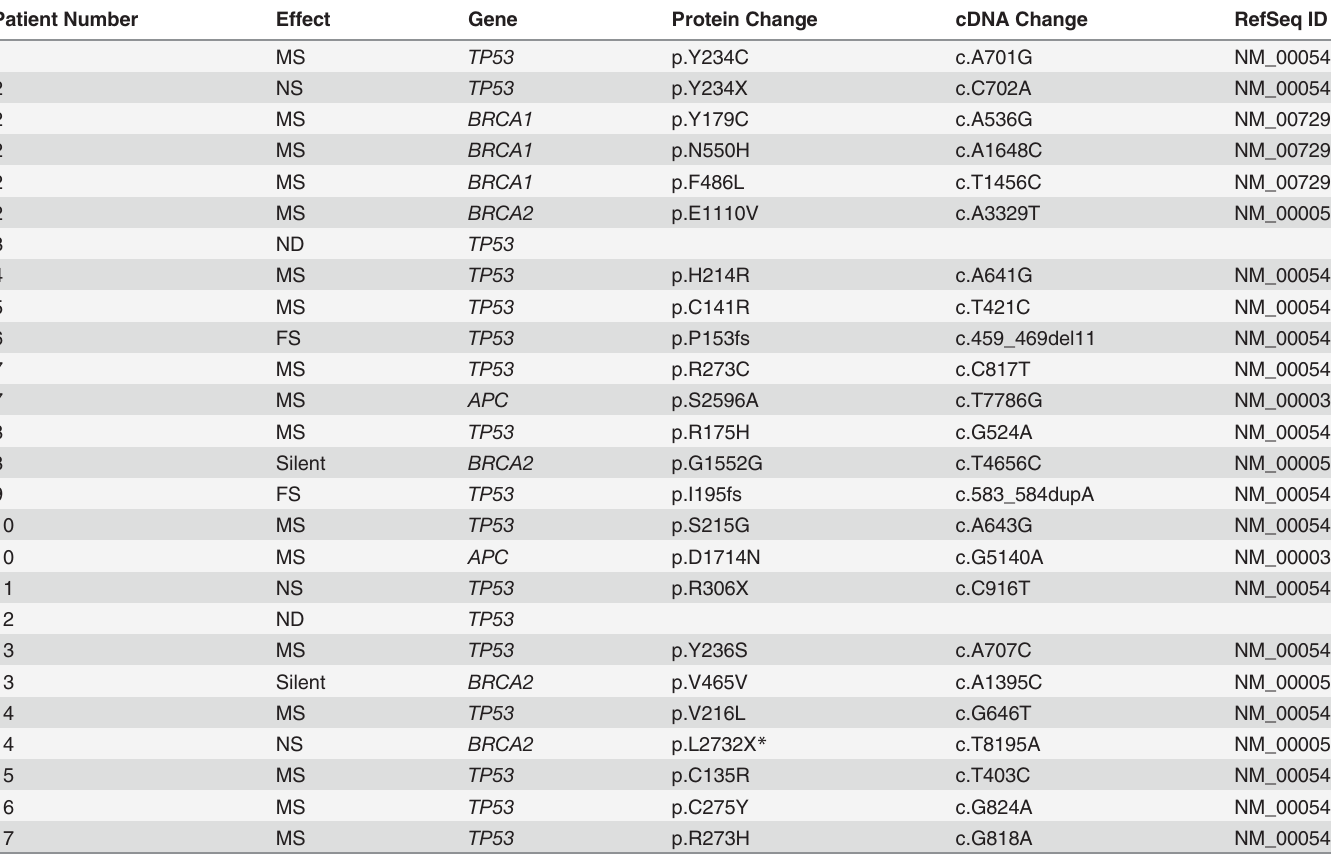
Table 2. Mutations detected in samples from CTCR-OV03 and CTCR-OV04 patients using TAm-Seq. Patient